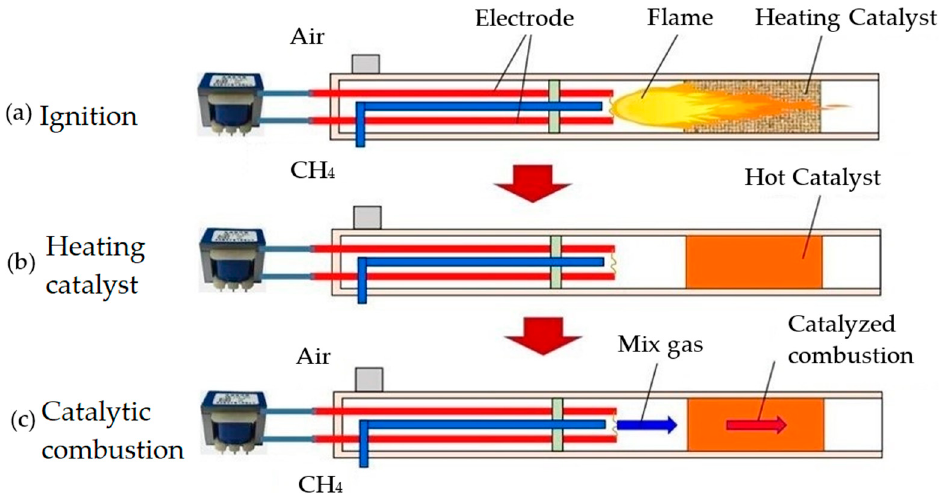
Figure 3. Working steps of downhole catalytic combustion.